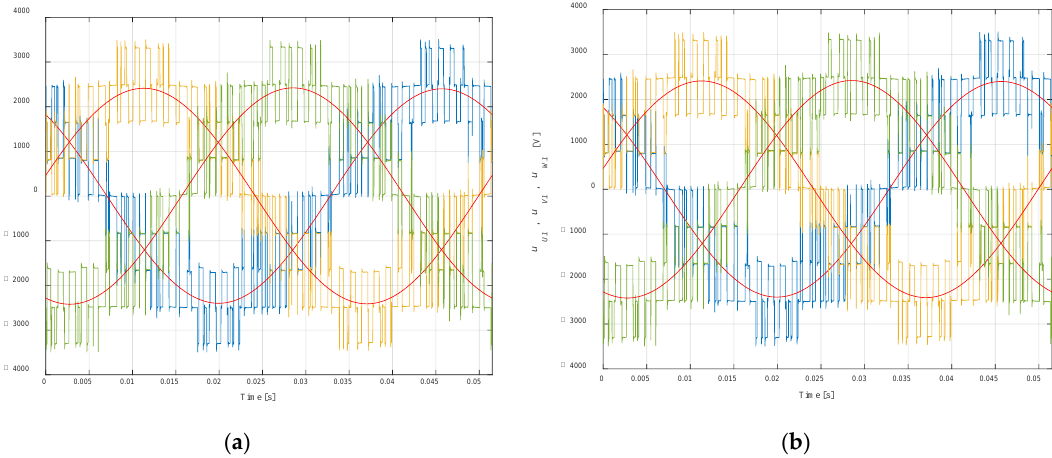
Figure 14. Waveforms of the voltages and currents measured at the machine terminals and their fundamental harmonics: ( a ) phase voltages, ( b ) total phase currents.